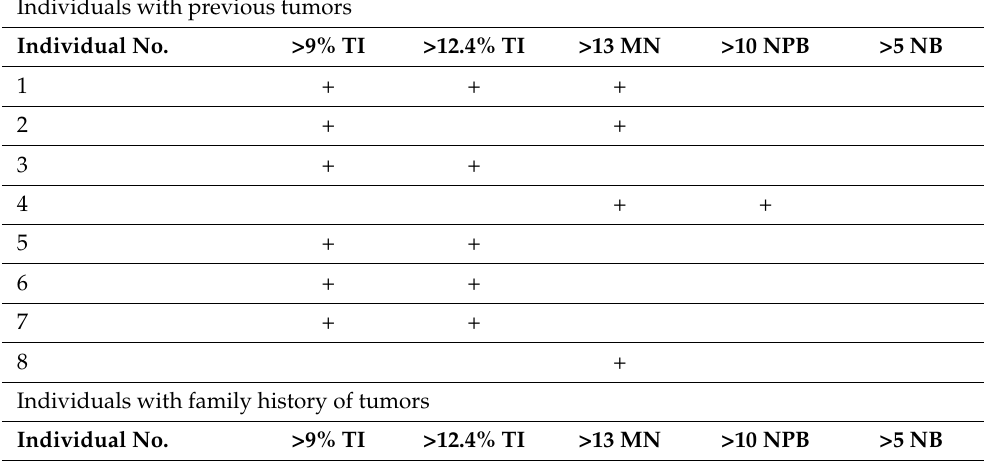
Individuals with family history of tumors Individual No. >9% TI >12.4% TI >13 MN >10